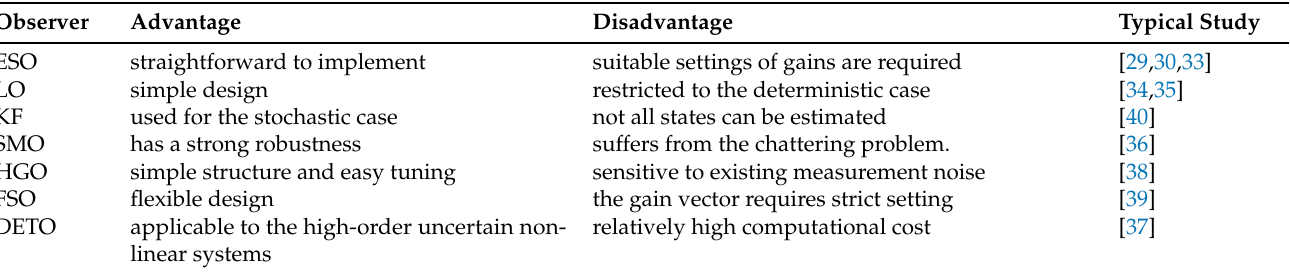
Table 2. Comparative analysis of the